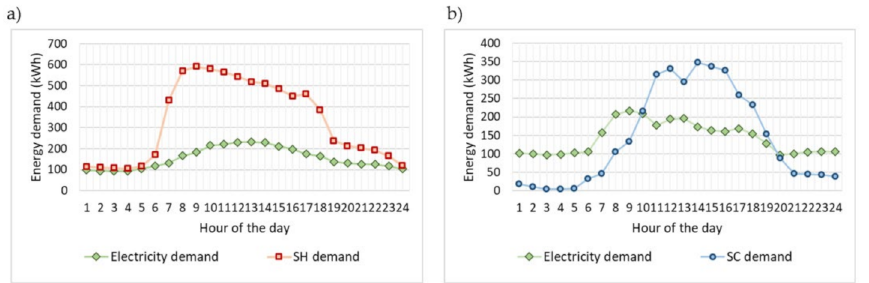
Figure 14. Hourly electrical and thermal demand profiles for the SPM: ( a ) representative winter day; ( b ) representative summer